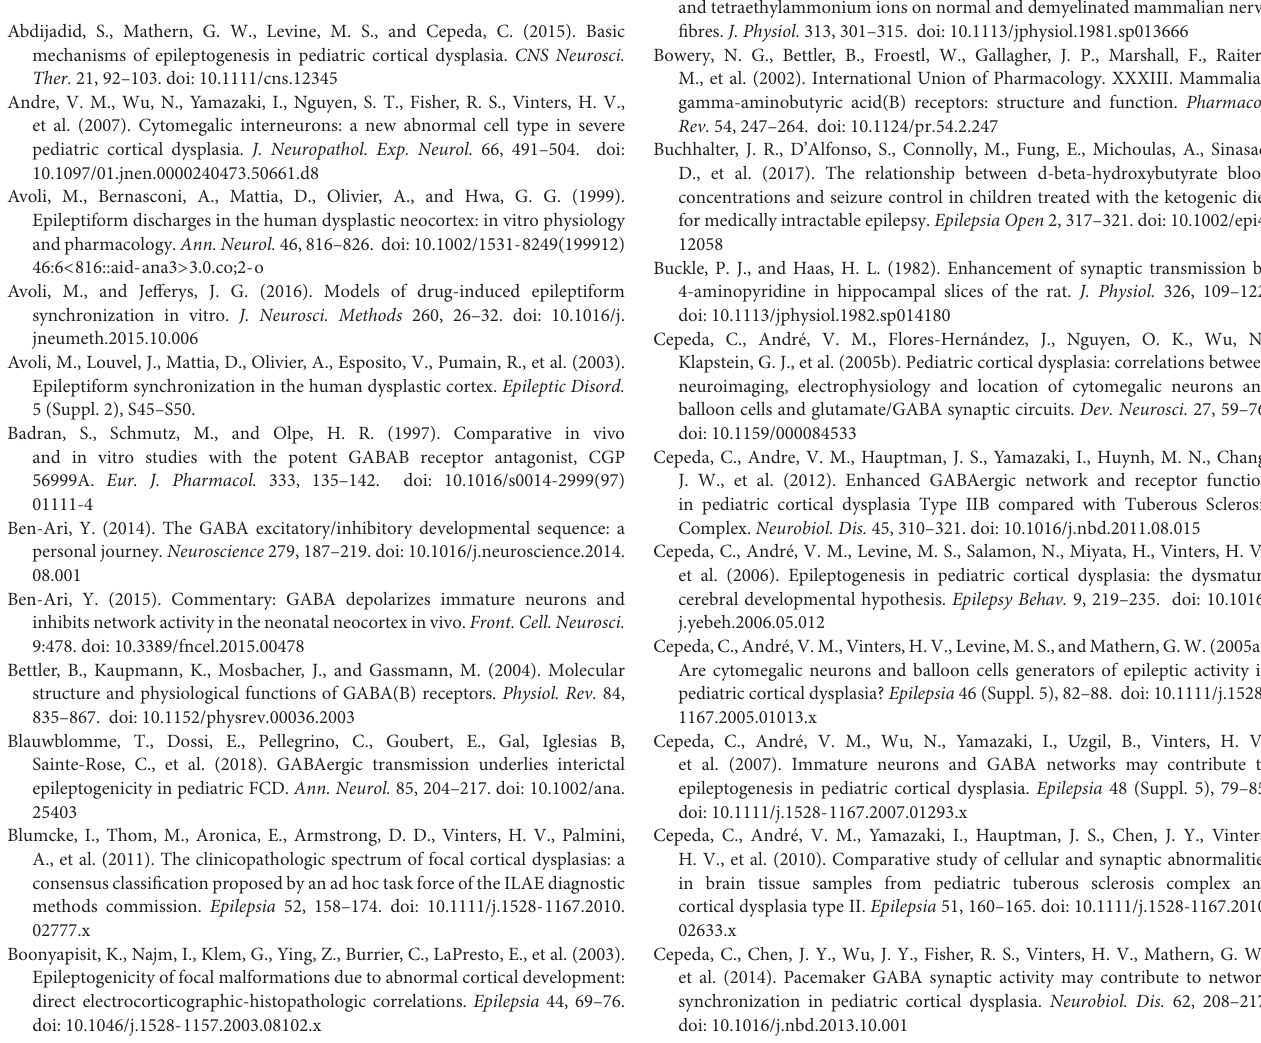
FIGURE S1 | Tetrodotoxin (TTX) and cadmium block 4-AP oscillations. (A) Voltage clamp recording (holding potential, Vh = + 10 mV) of a pyramidal neuron from a CD type IIb case. 4-AP oscillations were completely blocked after 3 min bath application of TTX. (B) Current clamp recording (at RMP) of a pyramidal neuron from a CD type I case. Cadmium blocked 4-AP oscillations after 3 min bath application. FIGURE S2 | 4-AP oscillations in balloon cells. (A) A balloon cell from a CD type IIb case was recorded and filled with biocytin. (B) Depolarizing current pulses were unable to induce action potentials (top right panel). However, bath application of 4-AP induced slow, small amplitude membrane depolarizations (bottom right panel), suggesting they might be sensing increases in K + concentration.